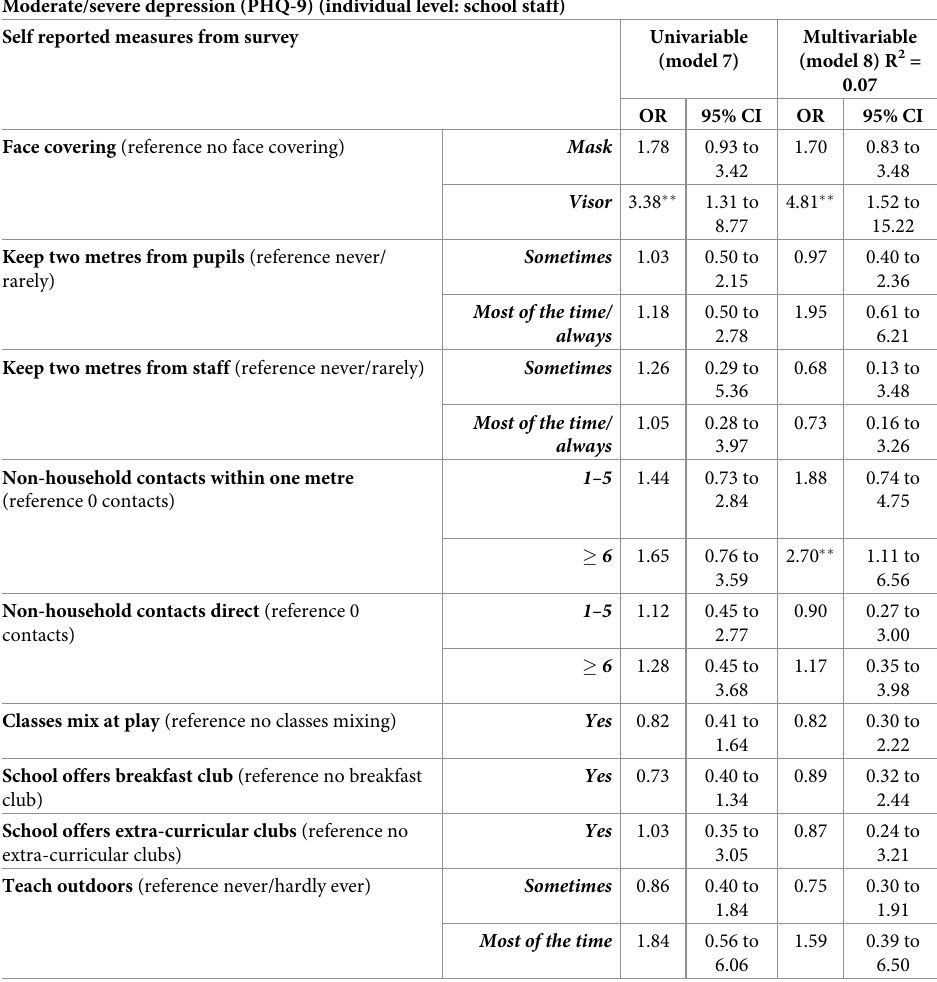
Multivariable (model 7) (model 8) R 2 = OR 95% CI OR 95% CI